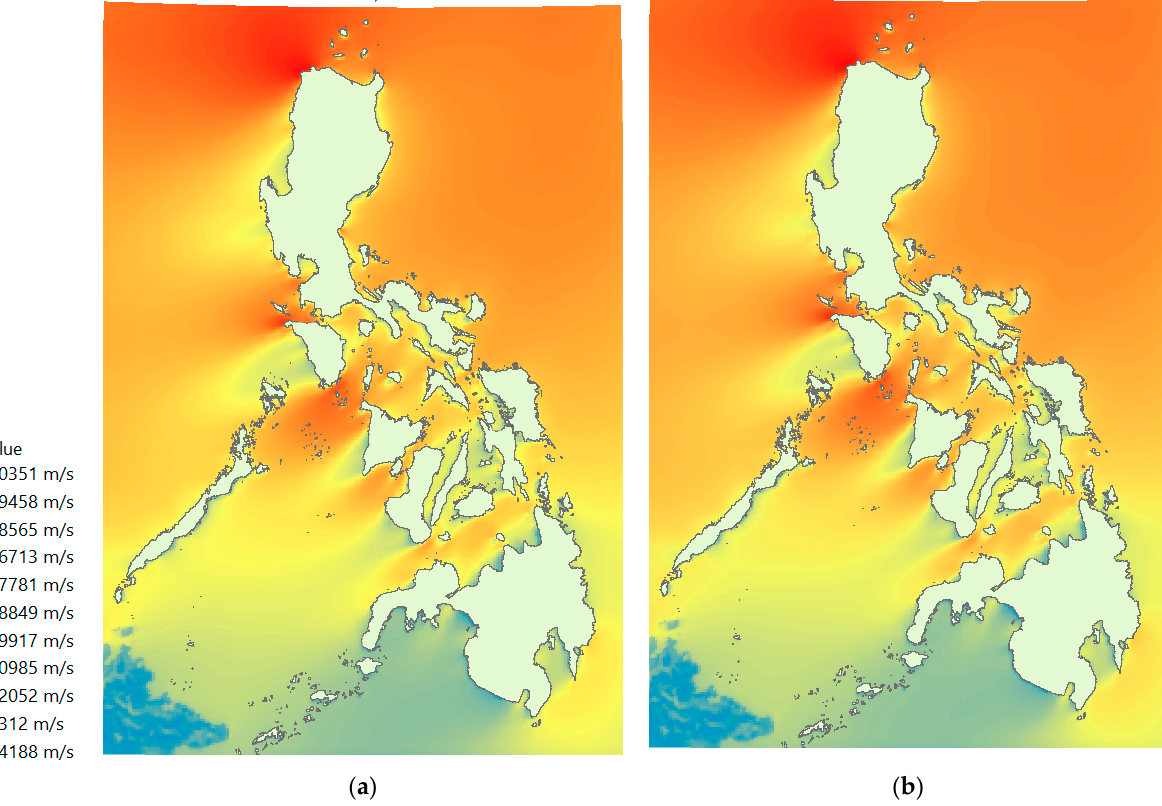
Figure 16. Wind speed at a hub height of ( a ) SWT-3.6-120 and ( b ) 6.2M126.